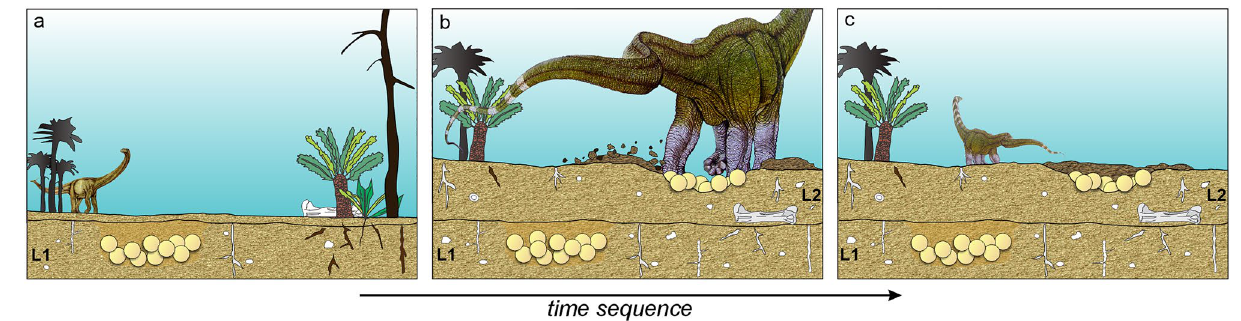
Figure 6. Model of events of titanosaur egg laying in two levels (L1 and L2), preservation, and subsequent sedimentation in the Ponte Alta nesting site. ( a ) First level of eggs. ( b ) Repeated selection of the laying area (by philopatry or breeding-site fidelity), excavation, and laying the eggs. ( c ) Covered eggs and a new